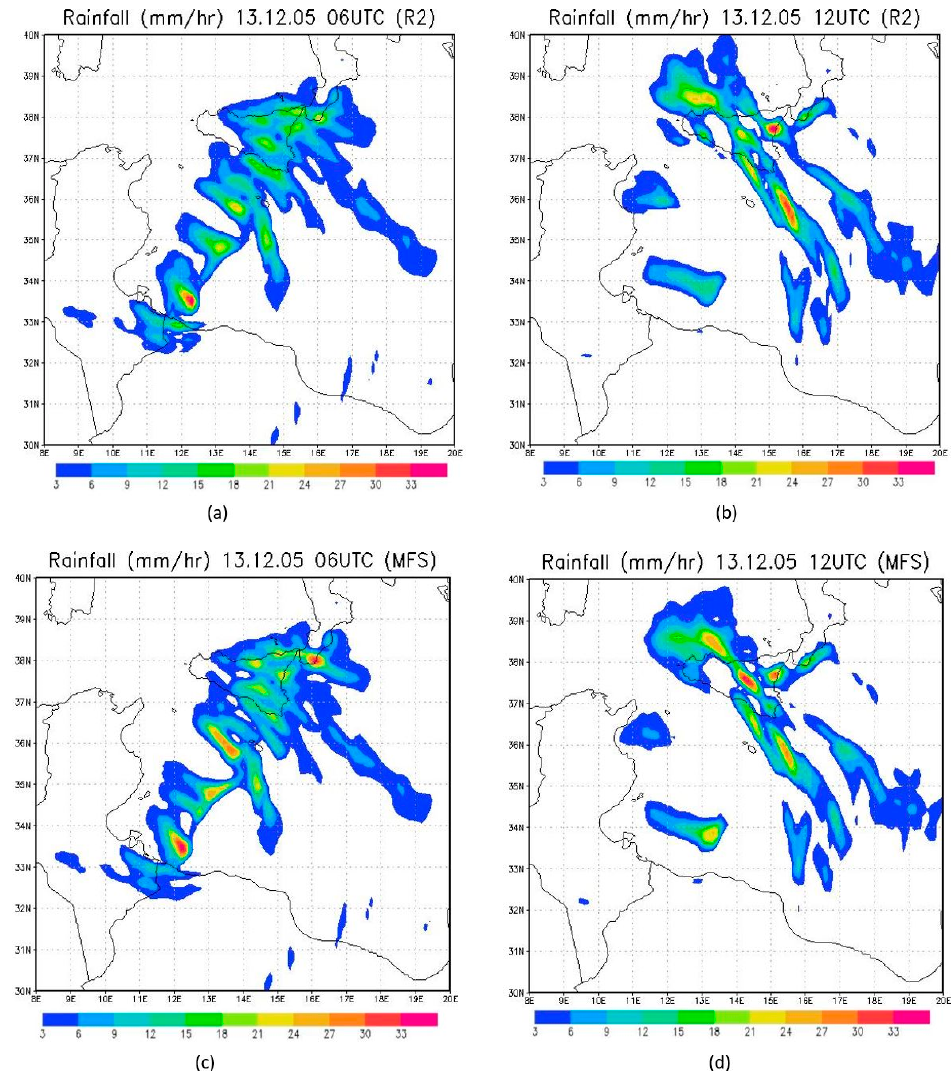
Figure 13. MSLP (hPa) on 14 December 2005 03UTC from ( a ) the R2 run and ( b ) the MFS run. The most intense rainfall occurred the day before the peak of the storm, between 06–12 UTC 13 December 2005 as shown in the TRMM data in Figure 4. The corresponding model results (3 h accumulated rainfall expressed in units of mm h − 1 ) for both model runs are shown in Figure 14. The general pattern, location and maximum rainfall rates over Sicily are reproduced reasonably well by the model although the precipitation appears is narrower bands as compared to the TRMM data. This may be partially due to the higher resolution of the model (10 km) compared to the TRMM fields (25 km).